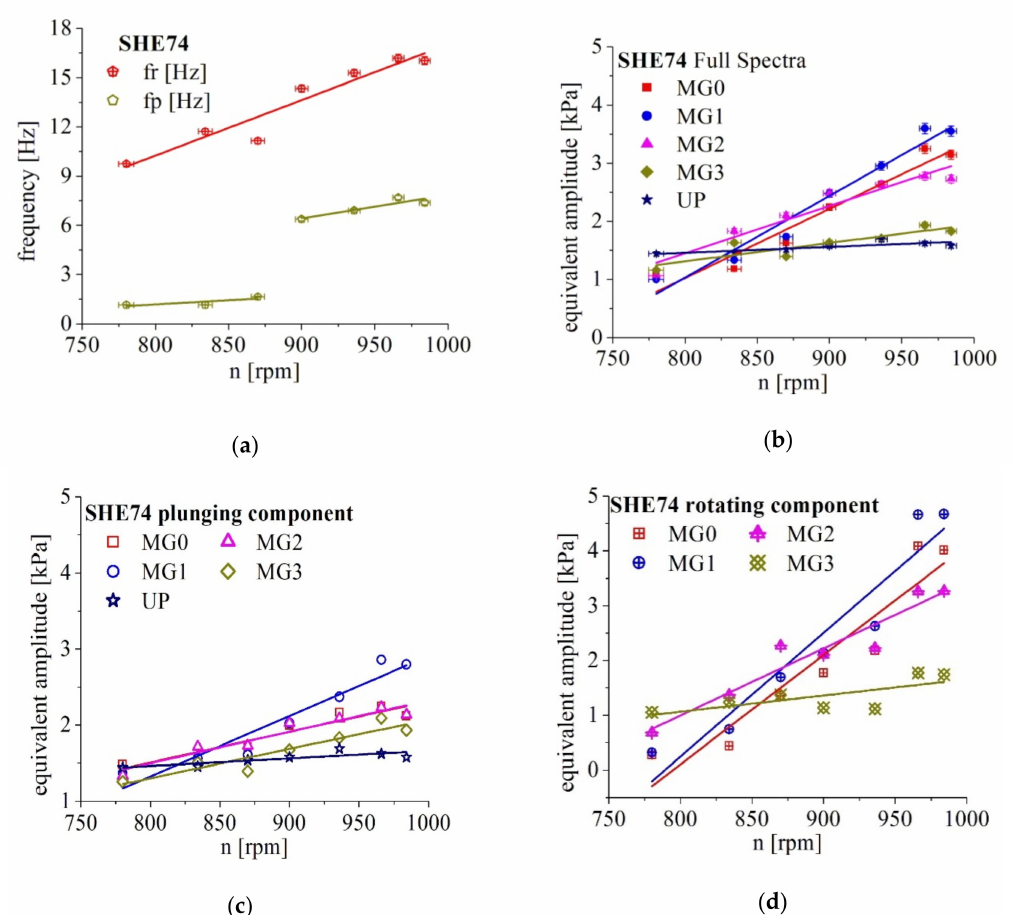
Figure 5. ( a ) Both fundamental frequencies corresponding to the rotating and plunging component generated in swirling flow with SHE74 draft tube versus the rotor speed; ( b ) The equivalent amplitude of the pressure pulsation power spectra on all level versus the rotor speed; ( c ) The equivalent amplitude of the plunging pressure pulsation on all levels versus the rotor speed; ( d ) The equivalent amplitude of the rotating pressure pulsation on MG0, MG1, MG2 and MG3 levels versus the rotor speed. Linear regressions of experimental data are marked with solid lines to highlight